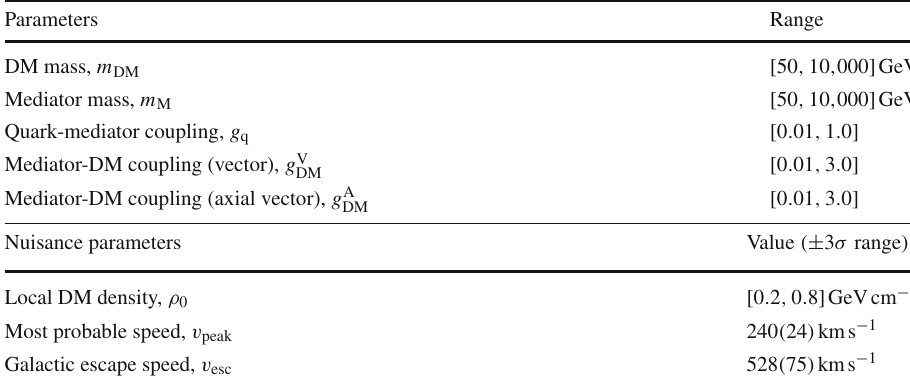
Table 3 Ranges scanned over for model and nuisance